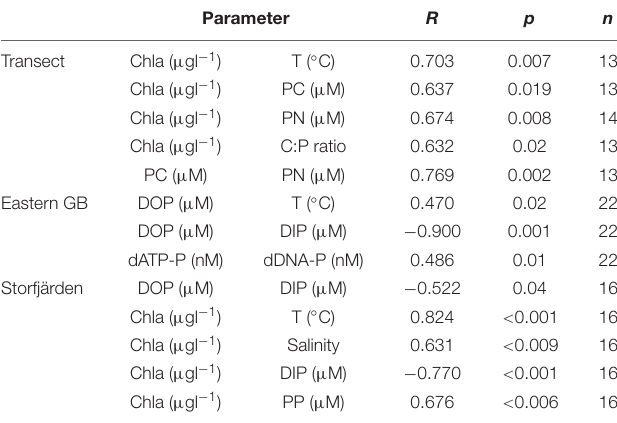
TABLE 4 | Relationships between DOP, dATP-P and Chla and other parameters that were significant in the Spearman Rank correlation test.